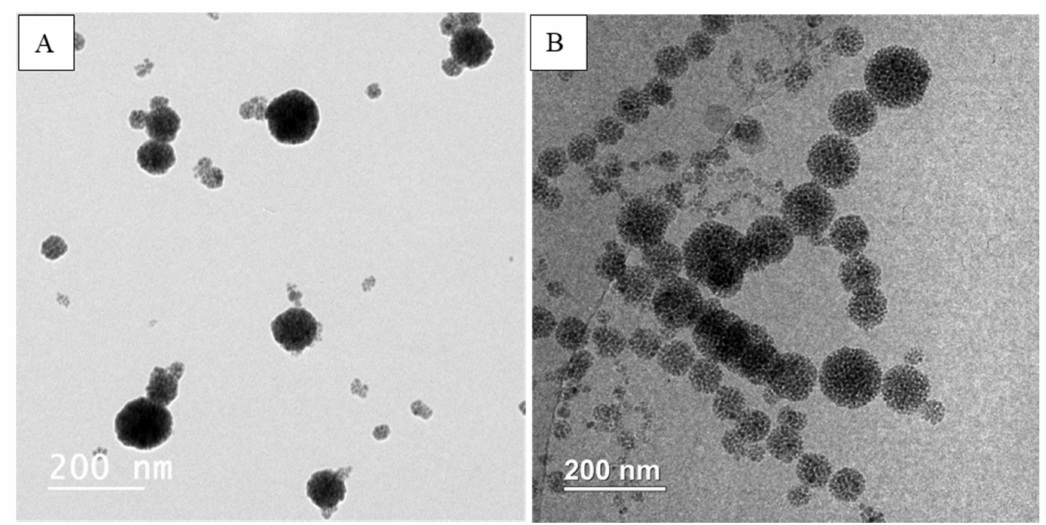
Figure 12. ( A ) TEM and ( B ) CryoTEM of